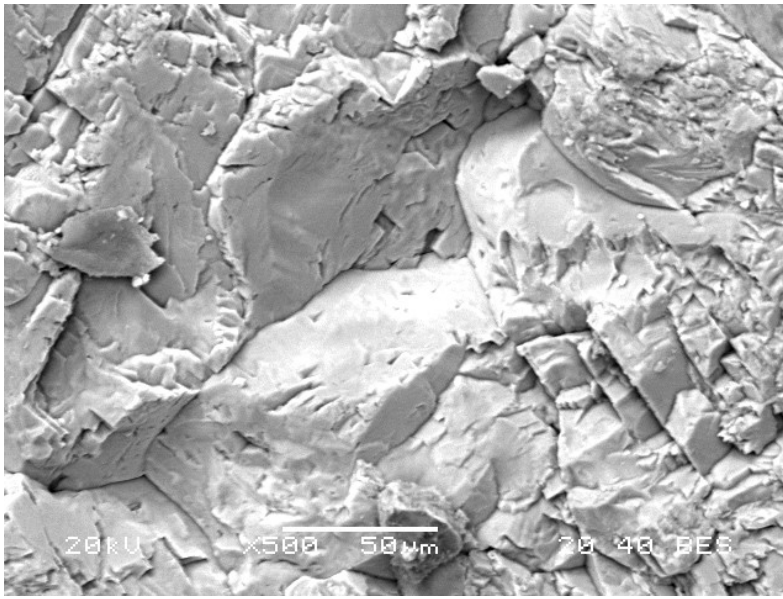
Figure 2. Grain free surfaces of unpolished specimens.